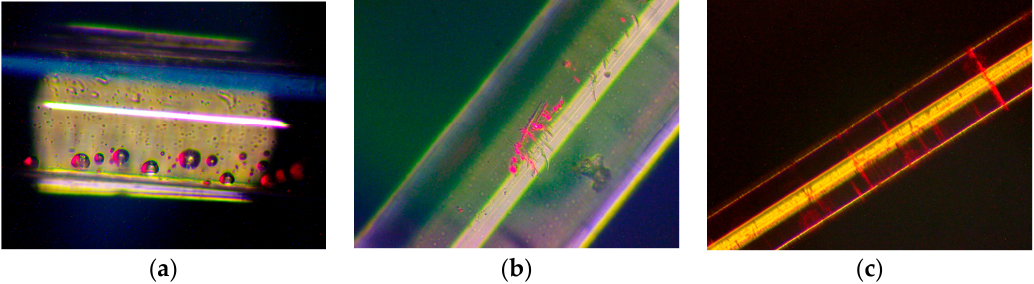
Figure 1. Flaws observed in the optical fiber structure: ( a ) bubbles in the polymer coating; ( b ) bruises on the fiber surface; ( c ) cracks on the fiber surface.